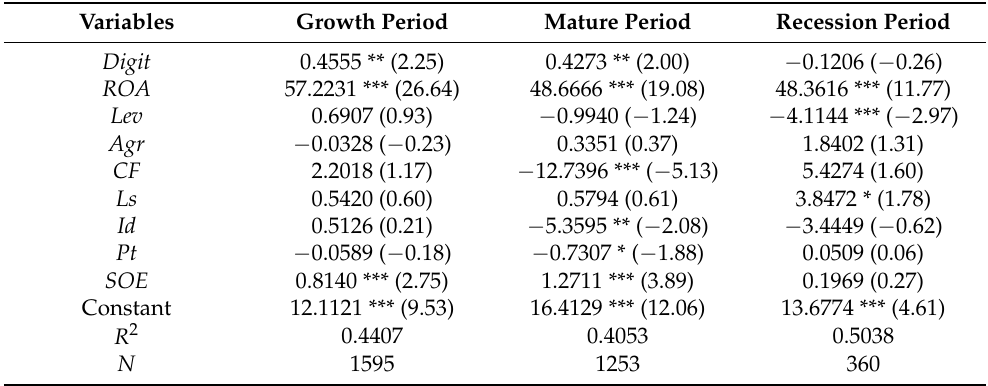
Table 13. Regression results of differentiating enterprise life cycle. Variables Growth